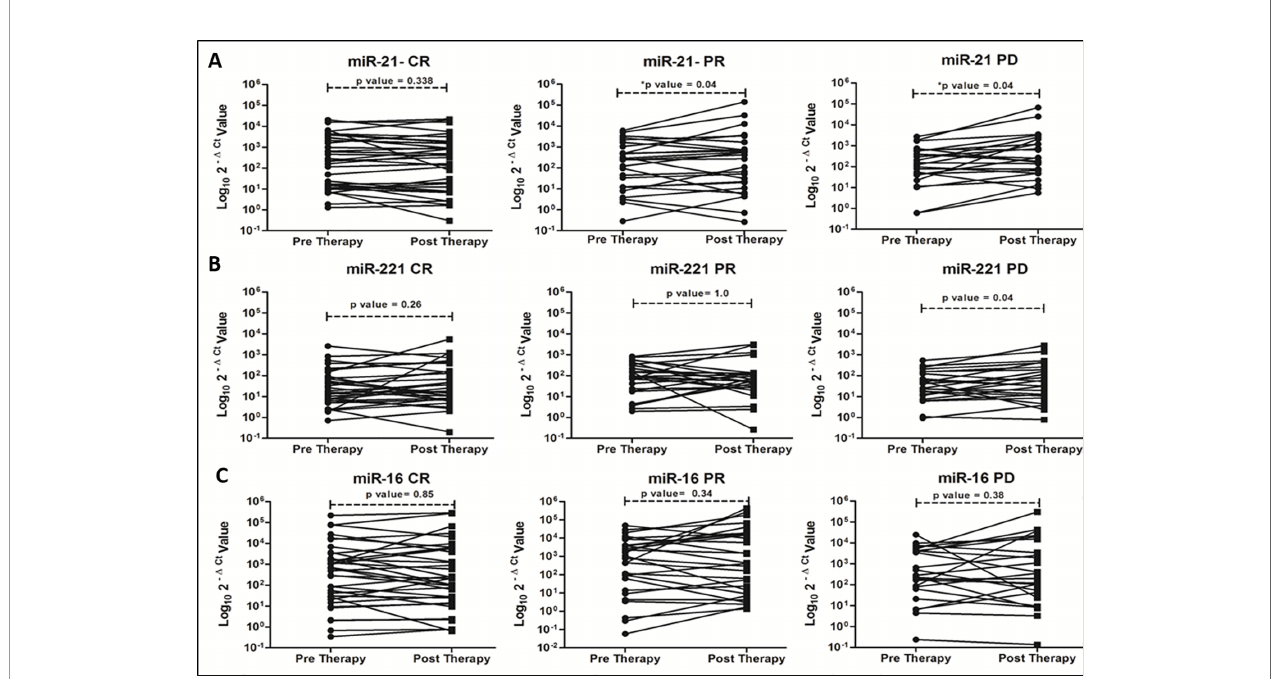
FIGURE 2 | Trends of oncomiR expression in different categories (CR, PR and PD) of tumor response at 1 month post-locoregional therapy in viral-HCC patients for miR-21 (A) , miR-221 (B) and miR-16 (C)